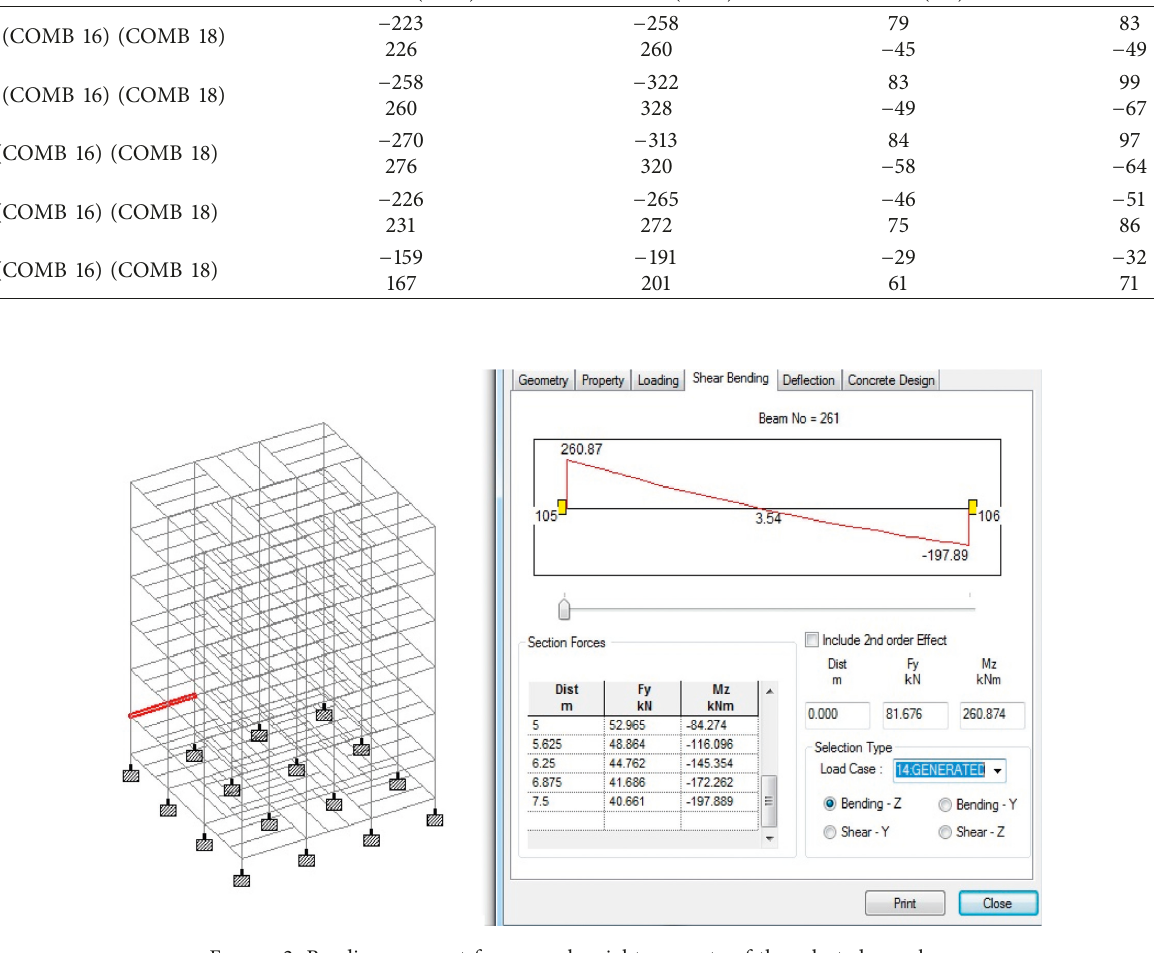
Figure 2: Bending moment for normal weight concrete of the selected member.